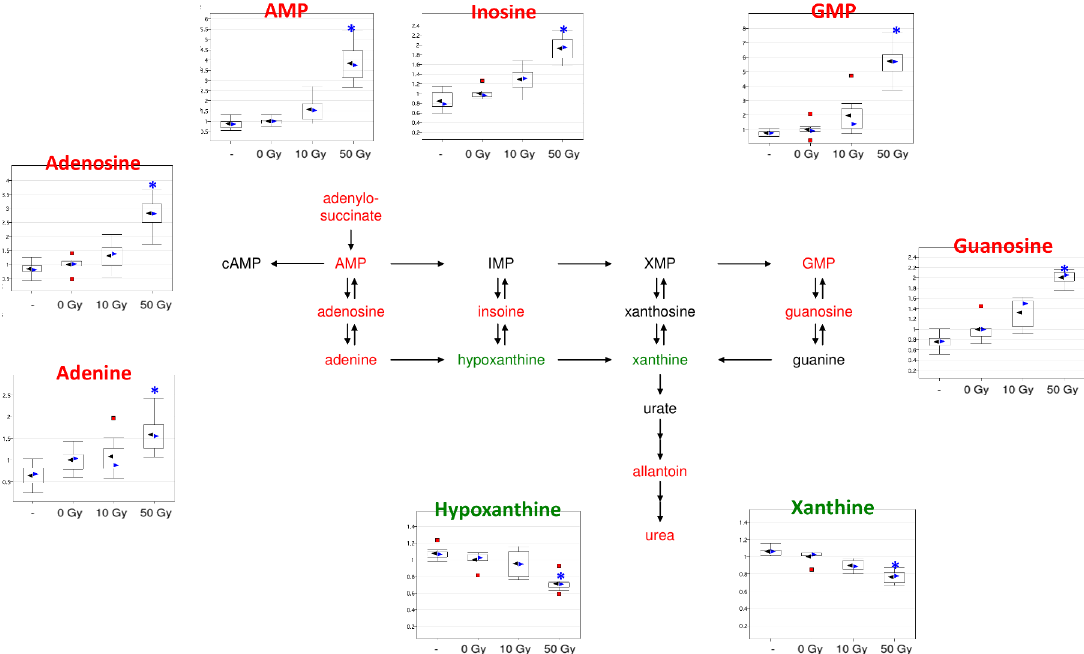
Fig 11. Purine Metabolism changes in response to liver irradiation. A general increase in purine metabolism intermediates may suggest increased breakdown of nucleotides in response to radiation perhaps as a mechanism to support repair after cell injury. Metabolites highlighted in green were decreased after liver irradiation relative to control while metabolites highlighted in red were increased.